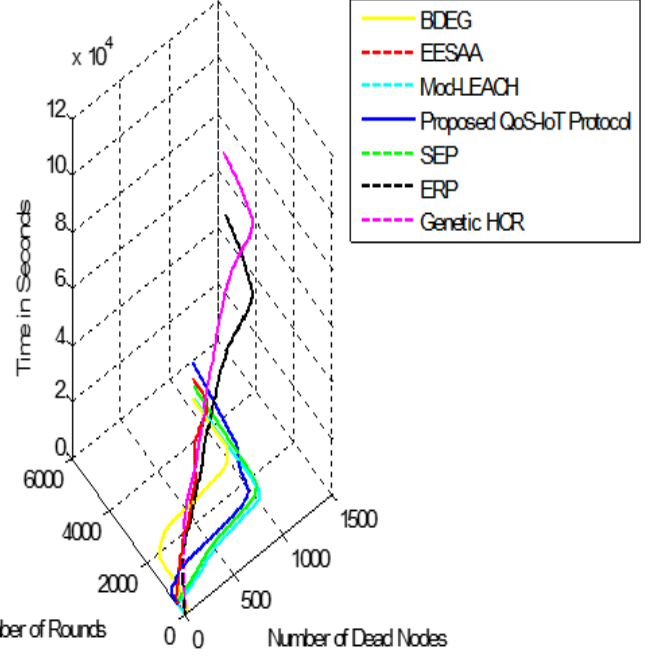
Figure 5. Network lifetime in reference to the energy depletion of